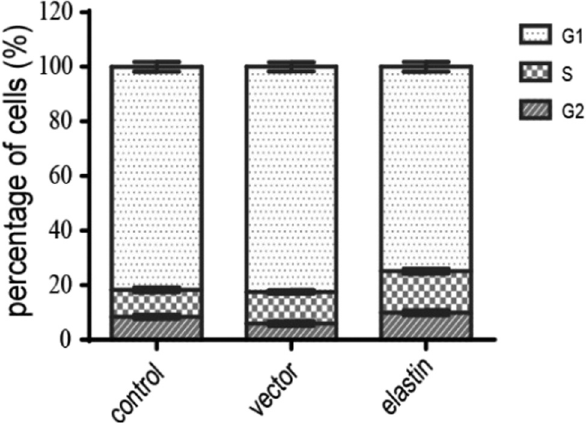
Figure 3: Flow cytometry identi fi cation of G1, S, and G2 ratio of BMSCs with di ff erent treatments.